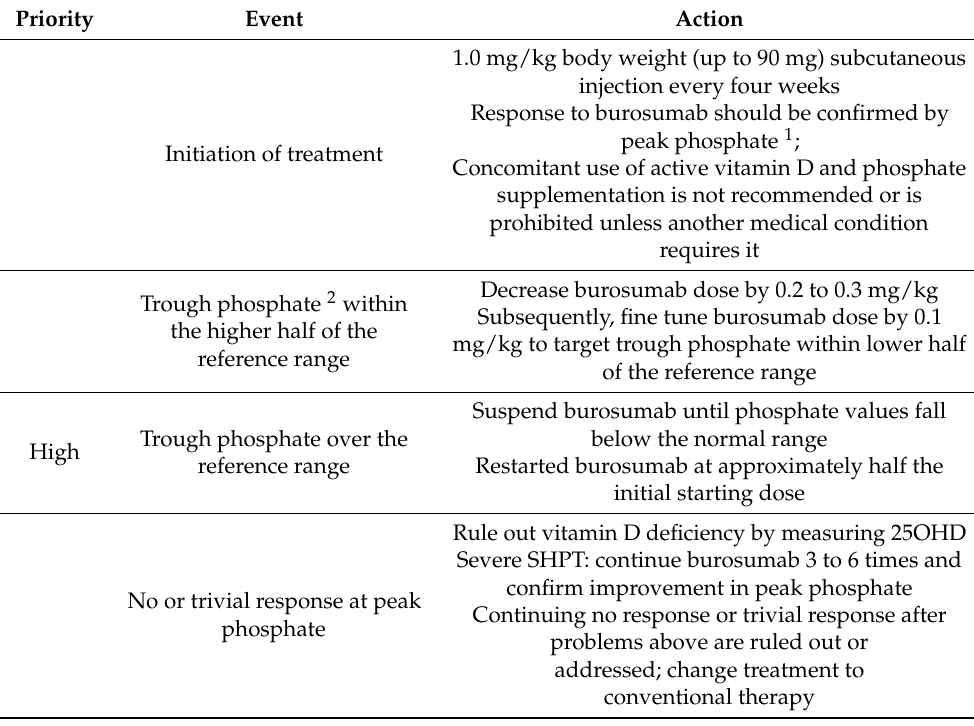
Table 3. Suggested guidance for the use of burosumab for adult XLH